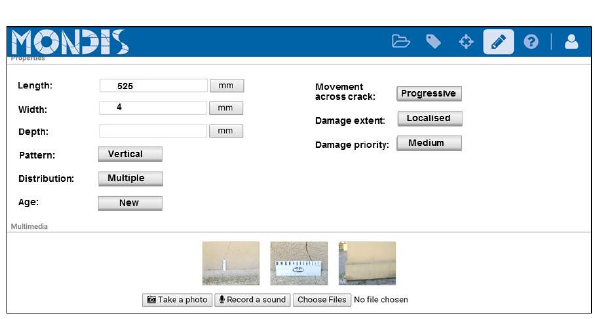
Figure 10. Crack detail